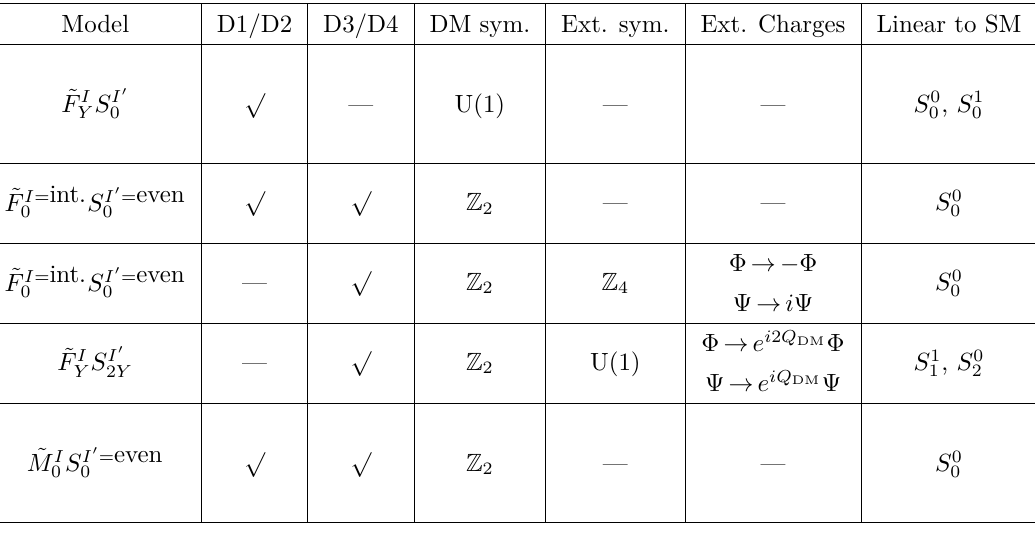
Table 2. Classification of models with a scalar even mediator multiplet. The extended symmetry in the fifth column refers to charges assigned to the scalar multiplet, as shown in the sixth column. In the last column we highlight scalar multiplets that allow for linear couplings to the SM that break the extended symmetry. For Majorana multiplets (last row), D3 ≡ D1 and D4 ≡ D2.